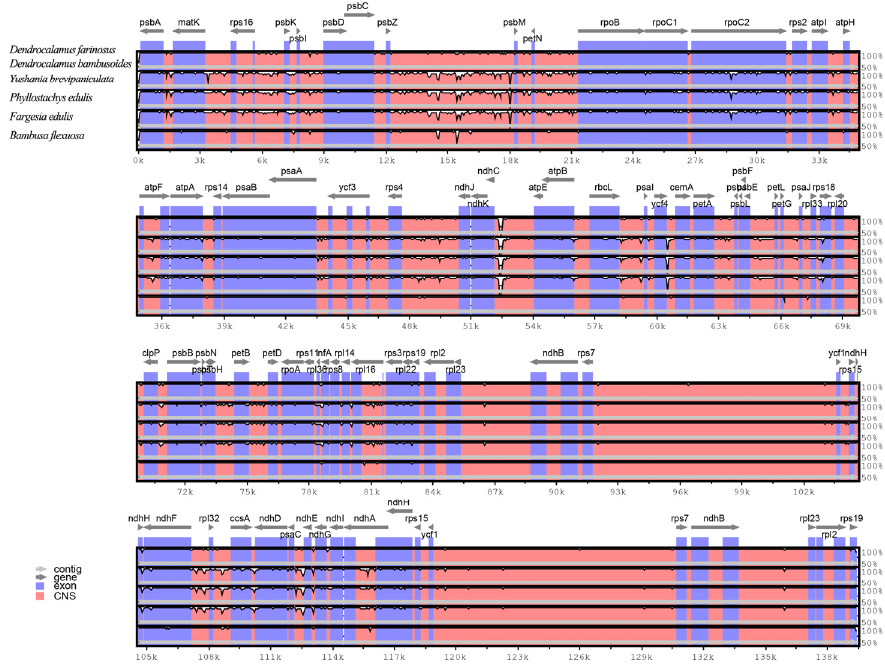
Figure 4. Sequence alignment of the six cp genomes of Bambusoideae with mVISTA using D. farinosus as a reference. The six genomes of Bambusoideae are D. farinosus , D. bambusoides , Y. brevipaniculata , Ph. edulis , F. edulis and B. flexuosa . The horizontal axis indicates the coordinates within the cp genome. Genome regions are color-coded as follows; genes are represented in blue; conserved non-coding sequences are represented in dark pink; forward and backward arrows represent the direction of the gene.